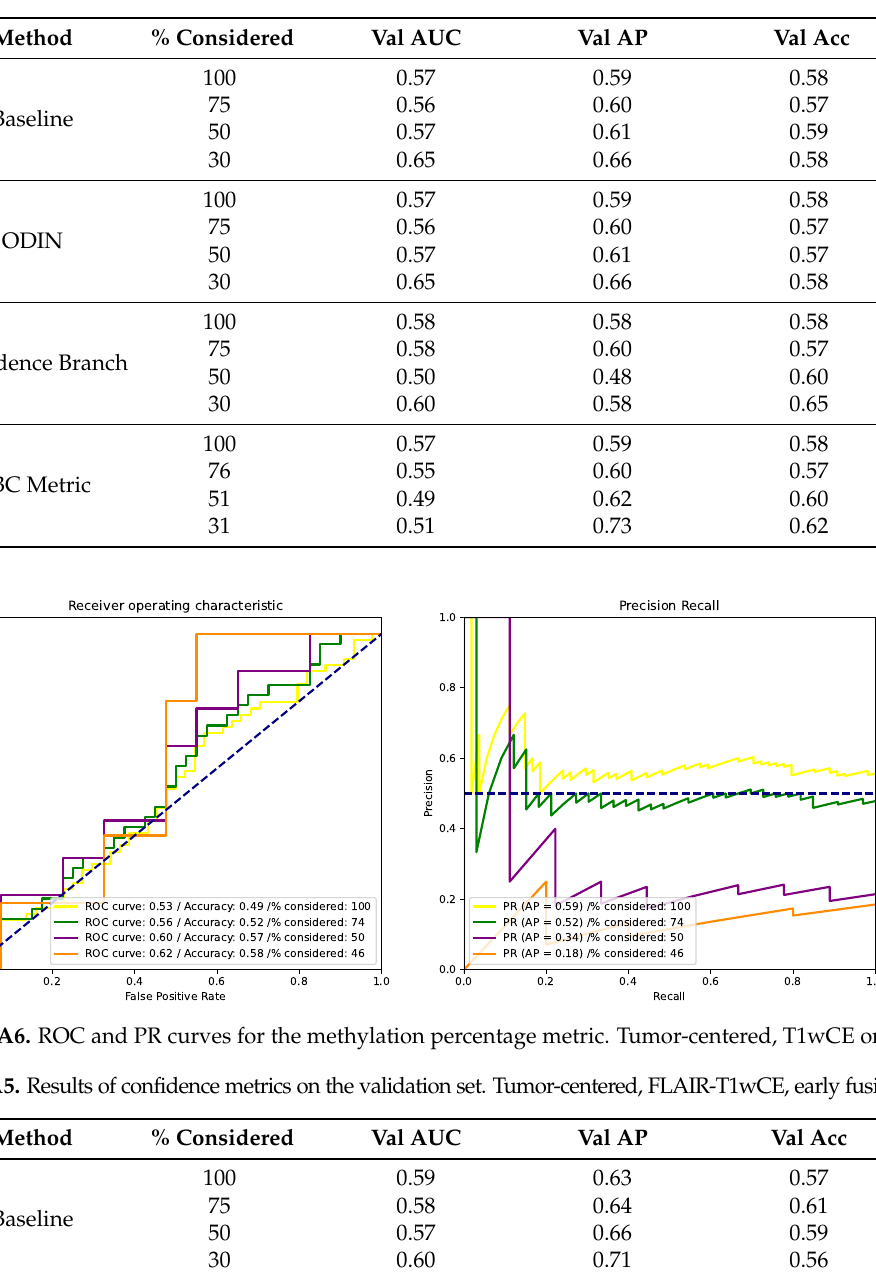
Table A4. Results of confidence metrics on the validation set. Tumor-centered, T1wCE only.